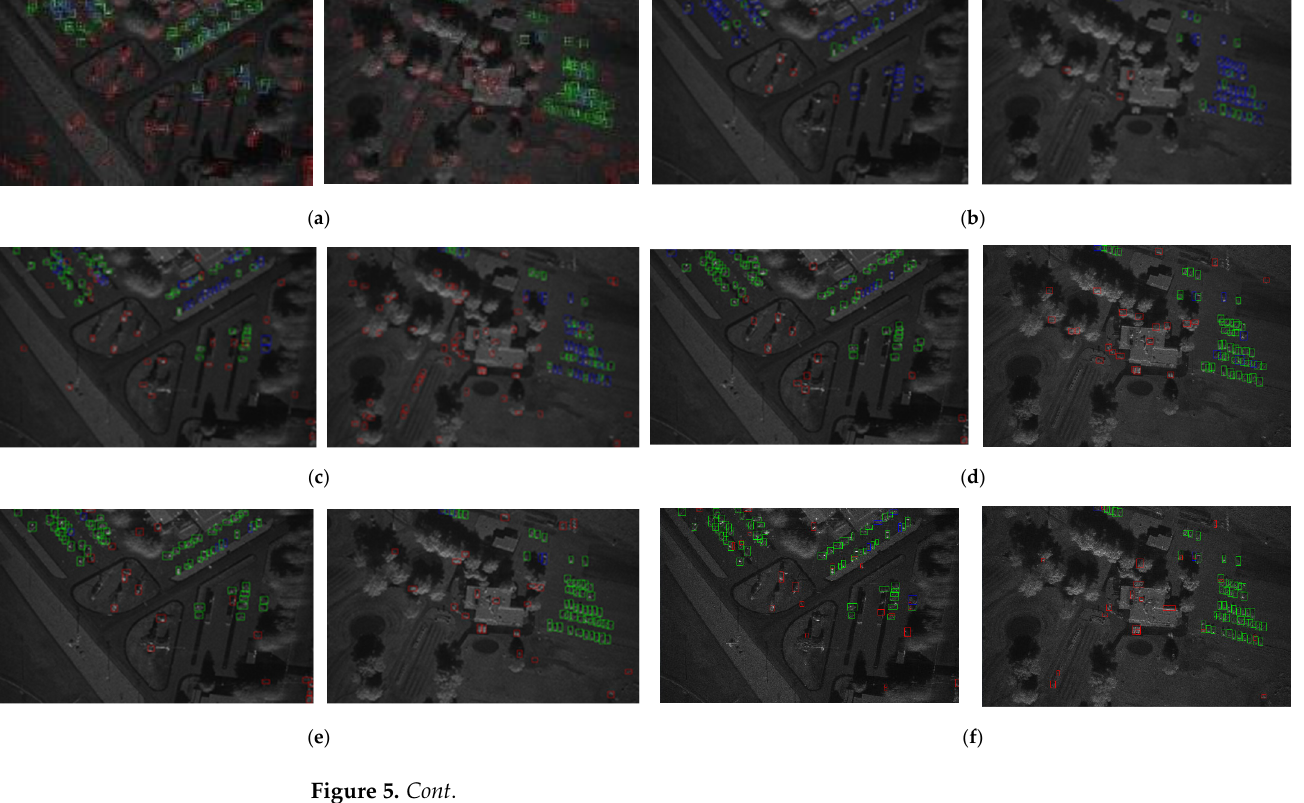
( j ) ( k ) Figure 5. The detection results of the proposed FDDA and some related methods for the two test images in the miniSAR dataset, where the green, red, and blue rectangles indicate the correctly de- tected cars, the false cars, and the missing cars, respectively. ( a ) Gaussian-CFAR. ( b ) DAF. ( c ) HTCN. ( d )